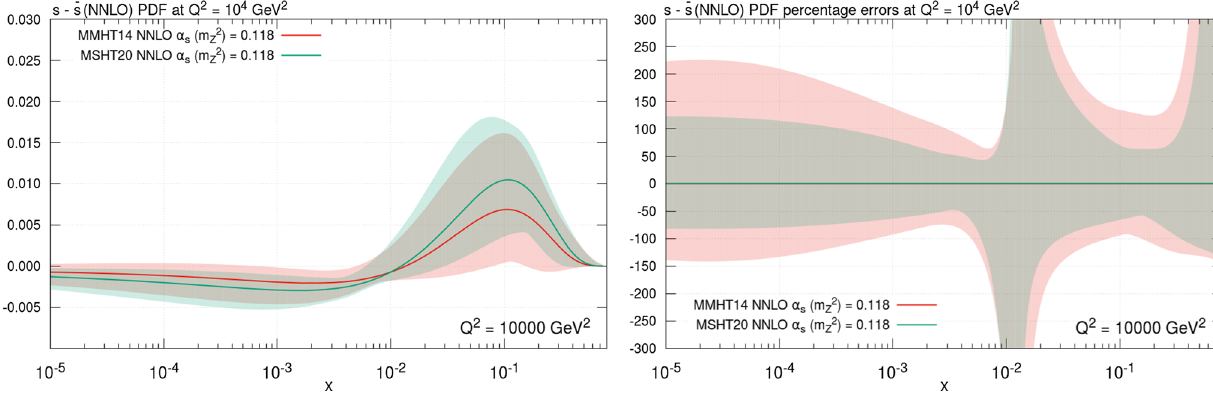
plot the percentage uncertainties are shown, however they become large in the regions where the asymmetry passes through or tends